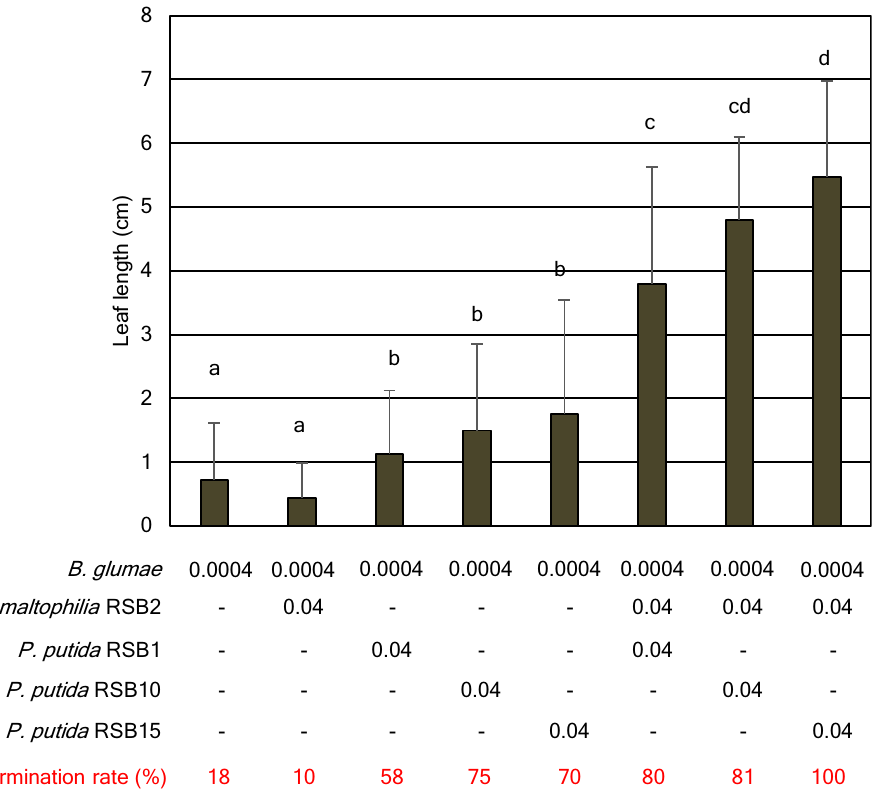
Figure 6. RSB1, RSB10, RSB15 and RSB2 coordinately suppressed growth inhibition caused by B. glumae . Leaf length of the seedlings were measured at 8 dpi (n = 20). Numbers under the figure indicate optical density